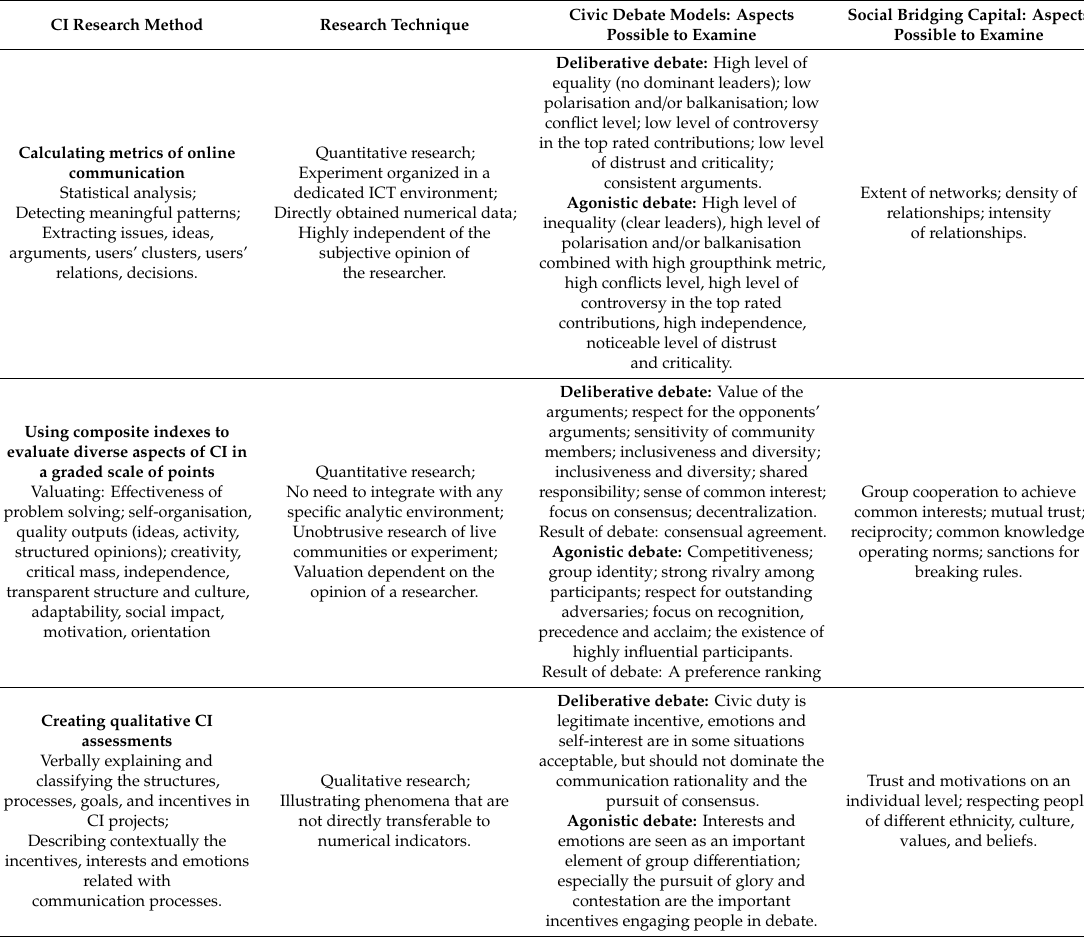
Table 1. Theoretical framework: Collective intelligence (CI) research methods, civic debate models and social bridging capital in online